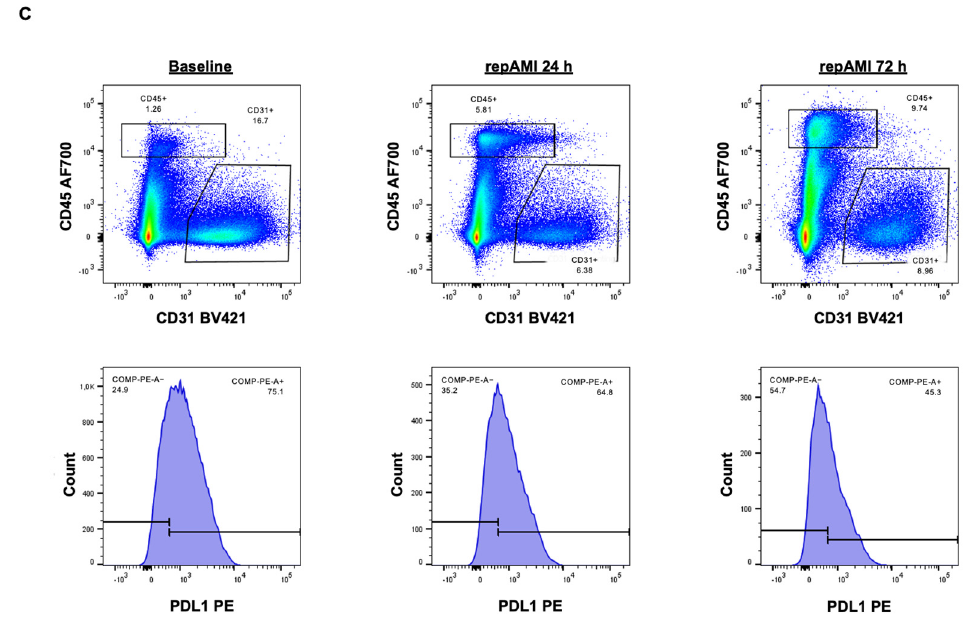
Figure 2. Decreased PDL1 expression following repAMI. ( A ) Scheme of flow cytometry-based analysis of immune cell analysis following collagenase digestion of left ventricular tissue. ( B ) Quantitative flow cytometry analysis showing decreased expression of the endothelial cell marker CD31 and decreased expression of PDL1 on endothelial cells following repAMI for 24 h or 72 h ( n = 16 for baseline, n = 8 for 24 h reperfusion time, n = 8 for 72 h reperfusion time). Black dots indicate individual samples. ( C ) Exemplary flow cytometry data showing increasing CD45 + leucocytes and decreasing PDL1 expression upon repAMI.